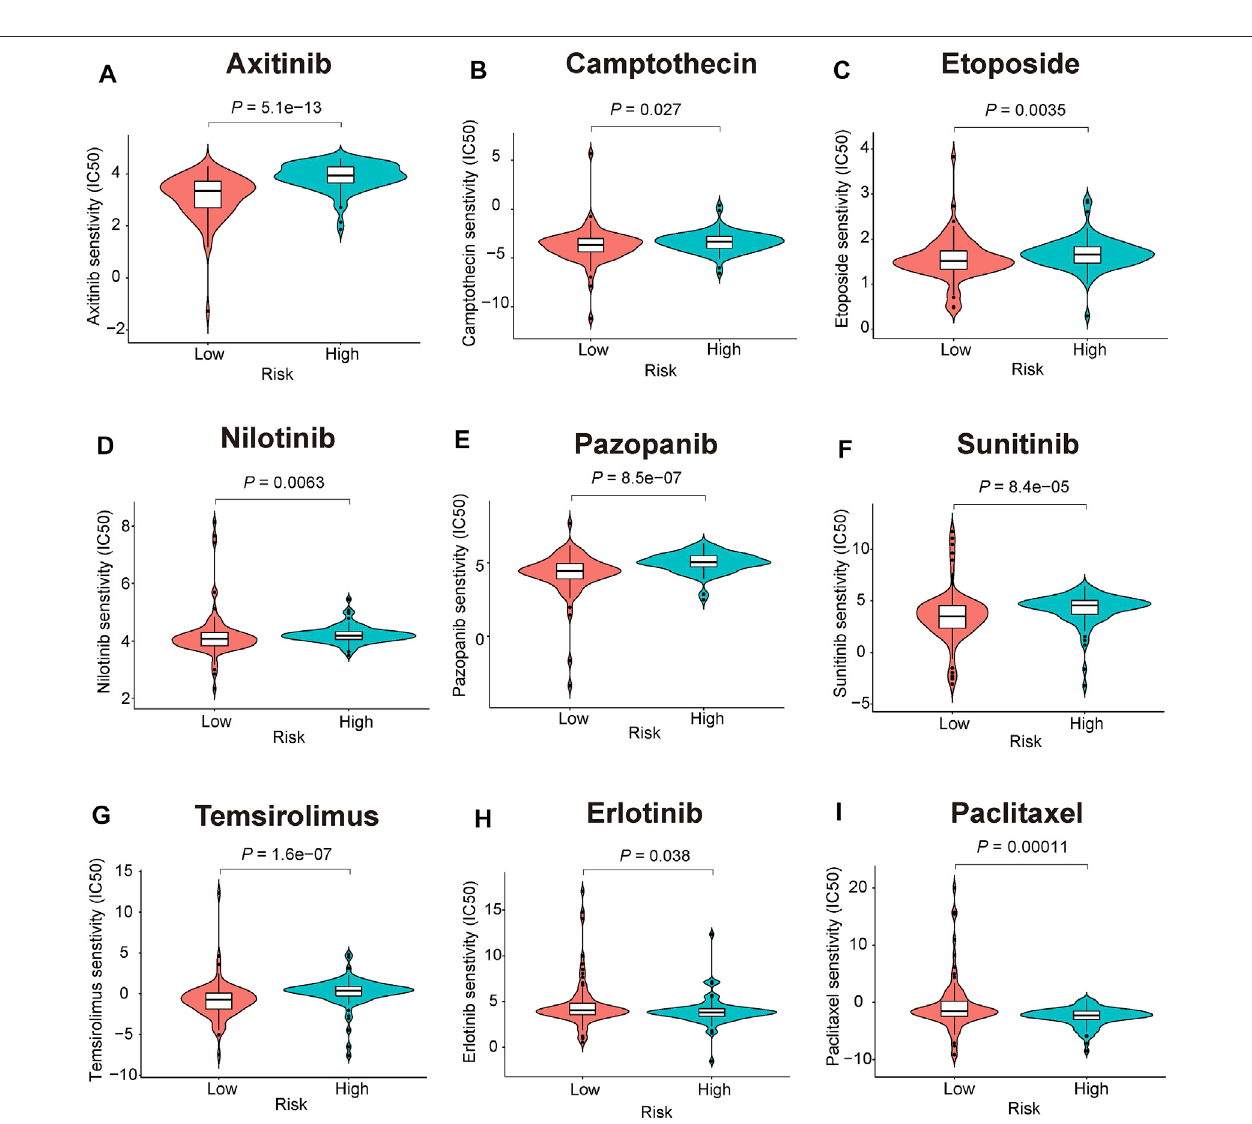
FIGURE 10 | Chemotherapeutic responses prediction of the 3-gene signature (A-I) Estimated IC50 for (A) , axitinib (B) , camptothecin (C) , etoposide (D) , nilotinib (E) , pazopanib (F) , sunitinib (G) , temsirolimus (H) , erlotinib (I) , paclitaxel.